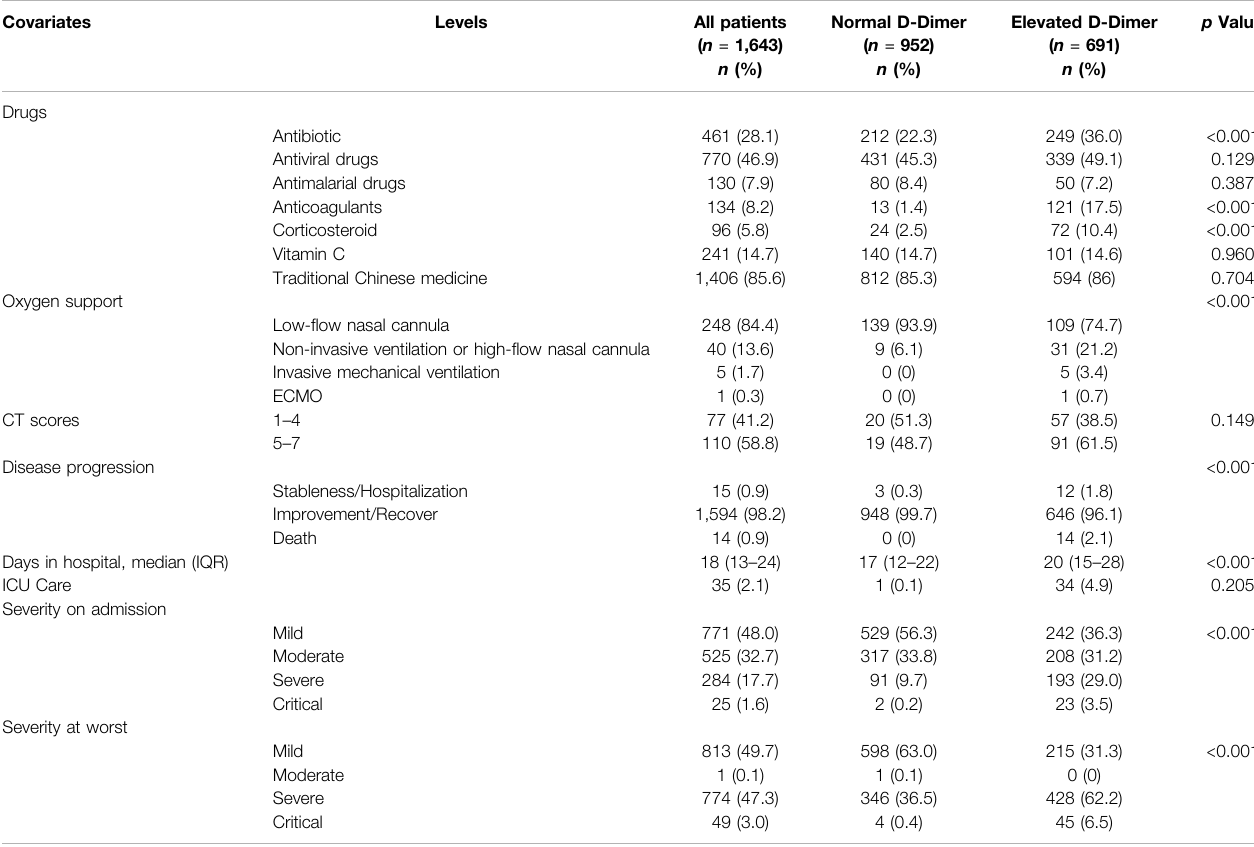
TABLE 6 | Clinical treatment and outcomes of 1,643 patients with COVID-19. Covariates